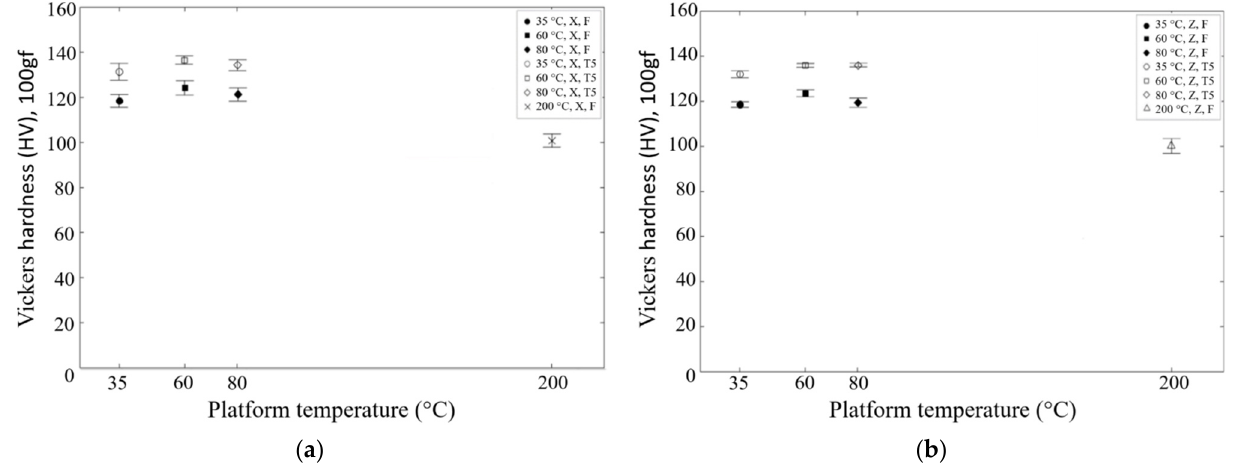
Figure 8. Vickers hardness of X-built ( a ) and Z-built ( b ) batches, HV 100 gf.